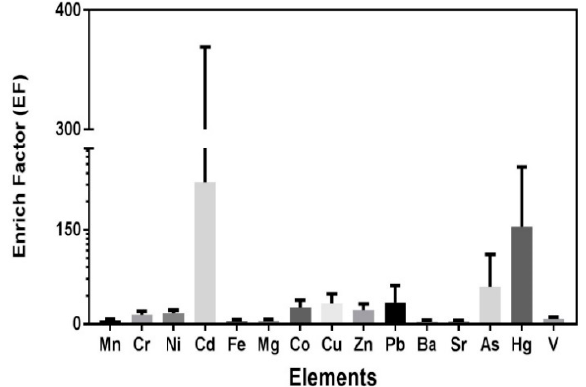
Figure 3. Boxplots of the enrichment factors (EF) for 16 elements in road dust.